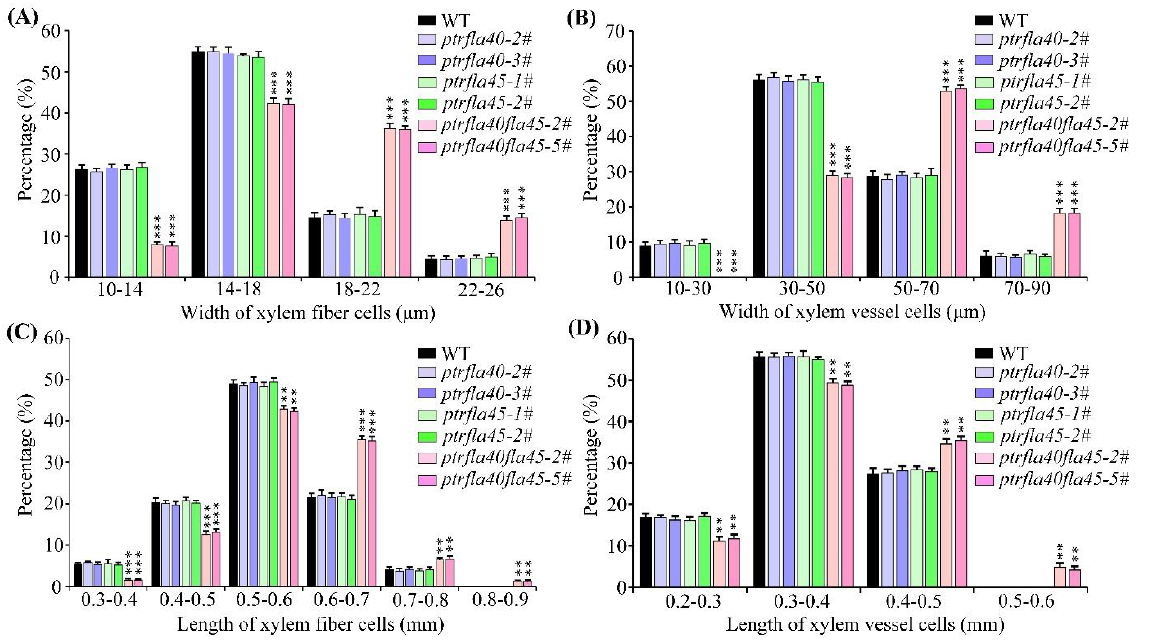
Figure 6. Statistical analysis of the width and length of xylem fiber and vessel cells in wild-type (WT), ptrfla40, ptrfla45, and ptrfla40fla45 mutants. ( A , B ) Transverse size percentages of the different subgroups of WT and mutant xylem fibers and vessels, respectively. ( C , D ) Percentage of the different subgroups of WT and mutant xylem fibers and vessels in longitudinal size, respectively. Student’s t -test: **, p < 0.01; ***, p < 0.001.